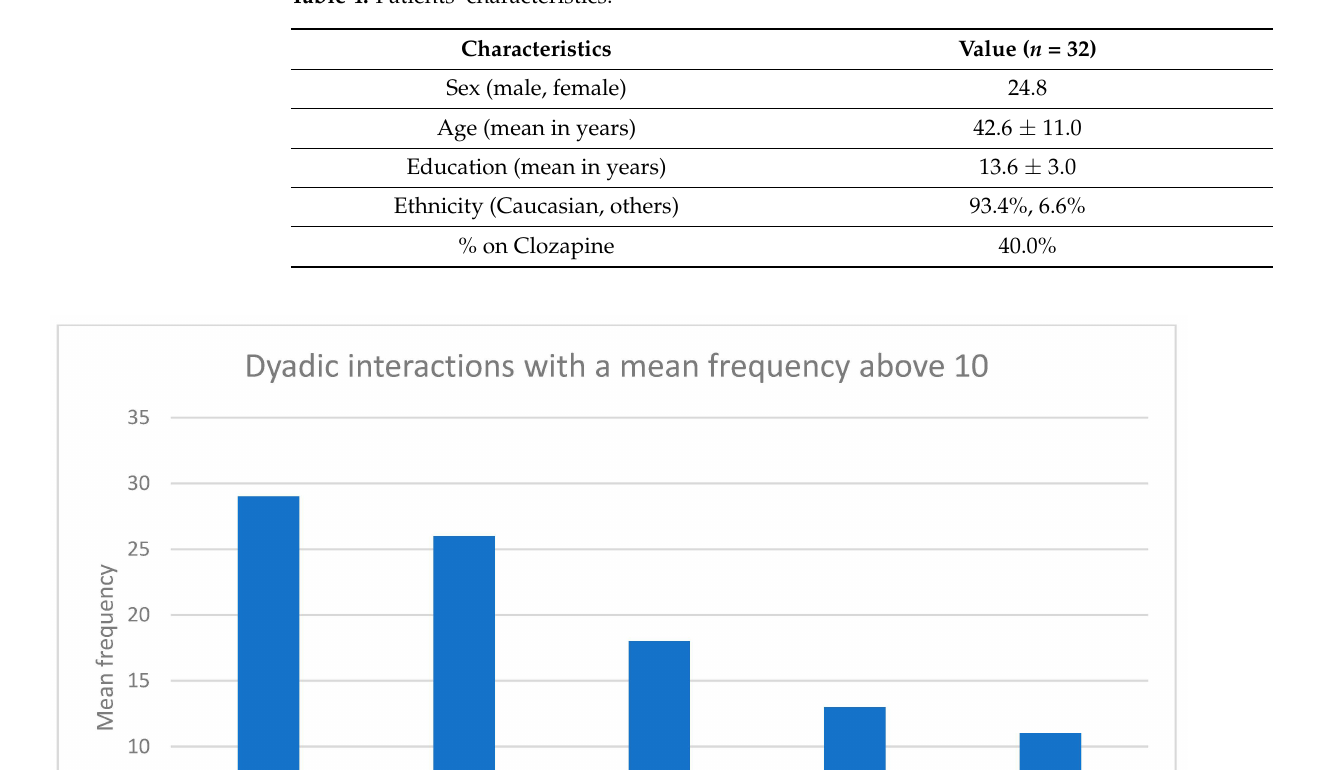
Table 4. Patients’ characteristics.